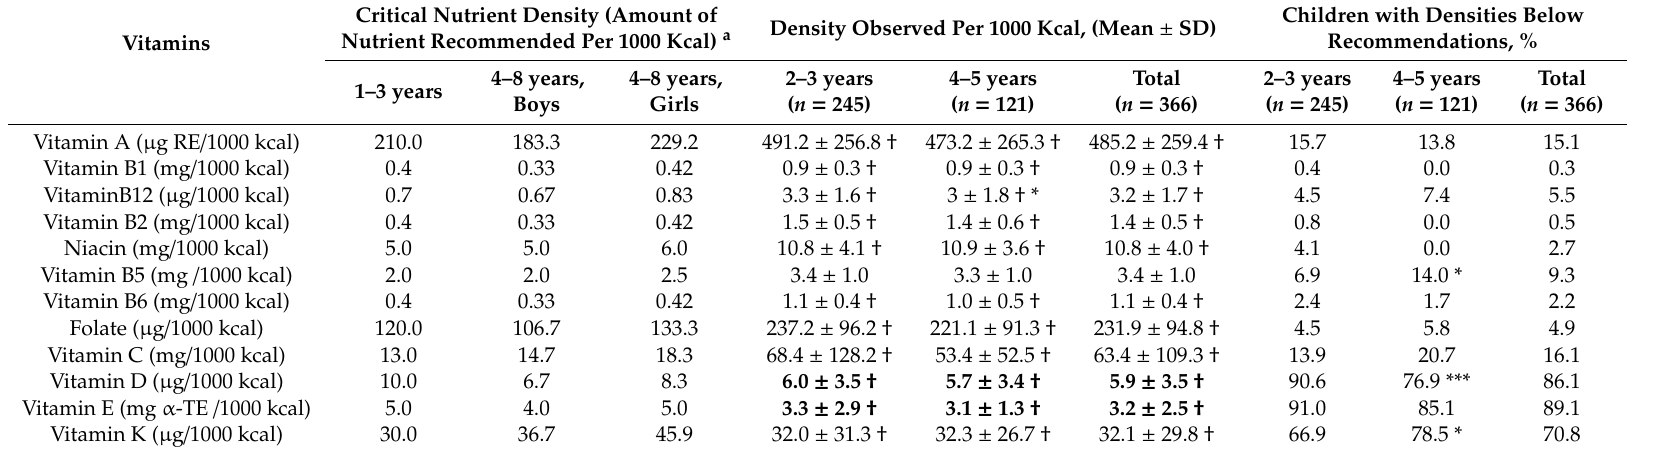
Table 2. Mean vitamin density per 1000 kcal and adequacy of vitamin intake by age